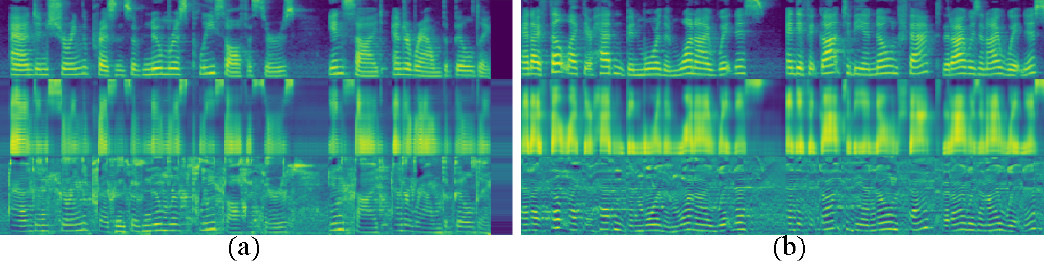
Figure 2. An example of mel spectrogram of the original speech, estimated mel spectrogram and estimated residual. ( a ) The mel spectrogram synthesized by the Es-Network; ( b ) The mel spectrogram synthesized by auto-encoder-based